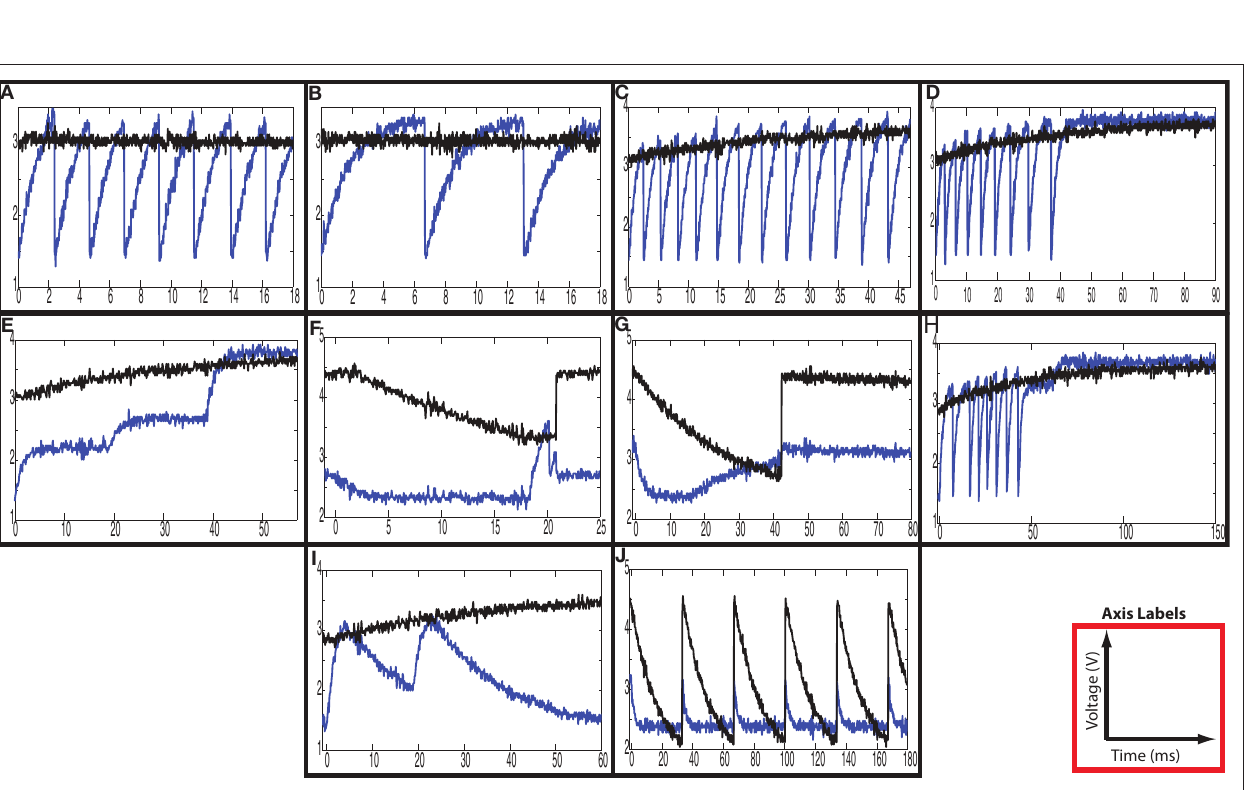
FIgure 19 | S-C Mihalas–Niebur neuron circuit results demonstrating 10 of the known spiking properties that have been observed in biological neurons. Membrane voltage and adaptive threshold are illustrated in blue and black respectively. (a) – tonic spiking, (b) – class 1 spiking, (C) – spike-frequency adaptation, (D) – phasic spiking, (e) – accommodation, (F) – threshold variability, (g) – rebound spiking, (H) – input bistability, (I) – integrator, (J) – hyper-polarized